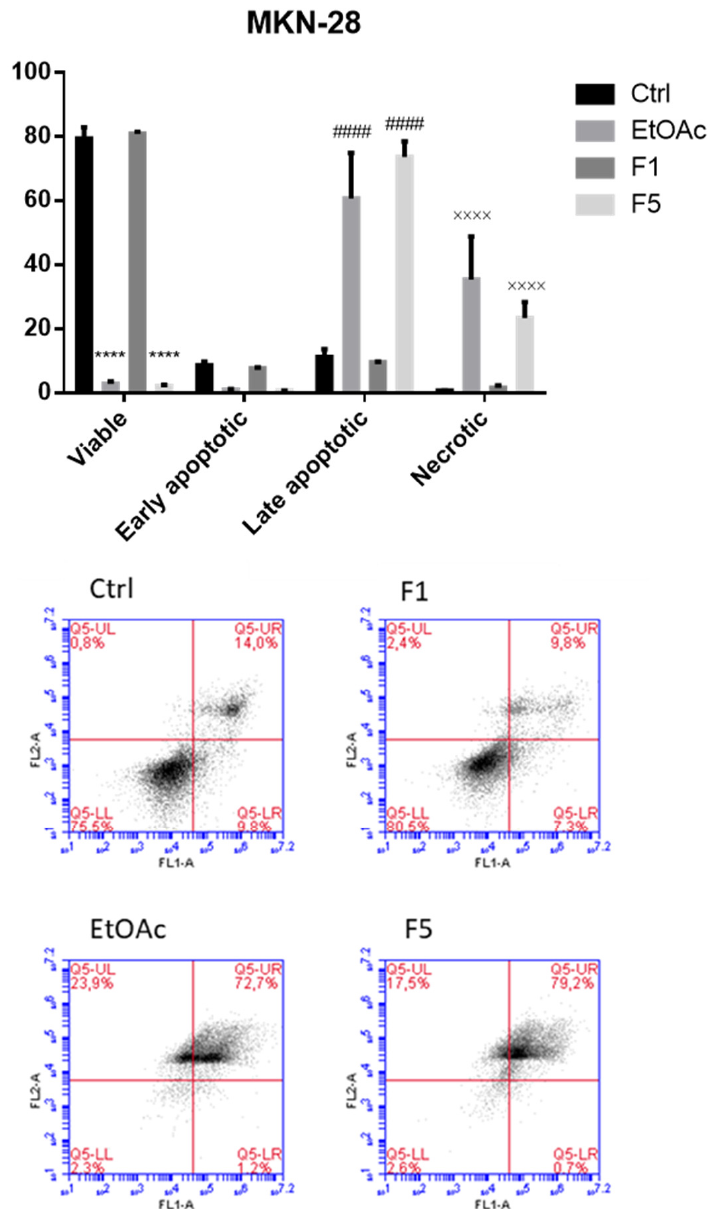
Figure 5. Detection of apoptosis/necrosis after 48 h treatment with F. vesiculosus samples via annexin V-FITC/PI labelling. The populations of early apoptotic cells, late apoptotic cells, necrotic cells, and viable cells were evaluated as a percentage of total cells and are presented as the means ± SEM of at least three independent experiments (**** p < 0.001 when compared with control; the symbols *, #, and × were used to express statistical significance within the viable, apoptotic, and necrotic cells, respectively).